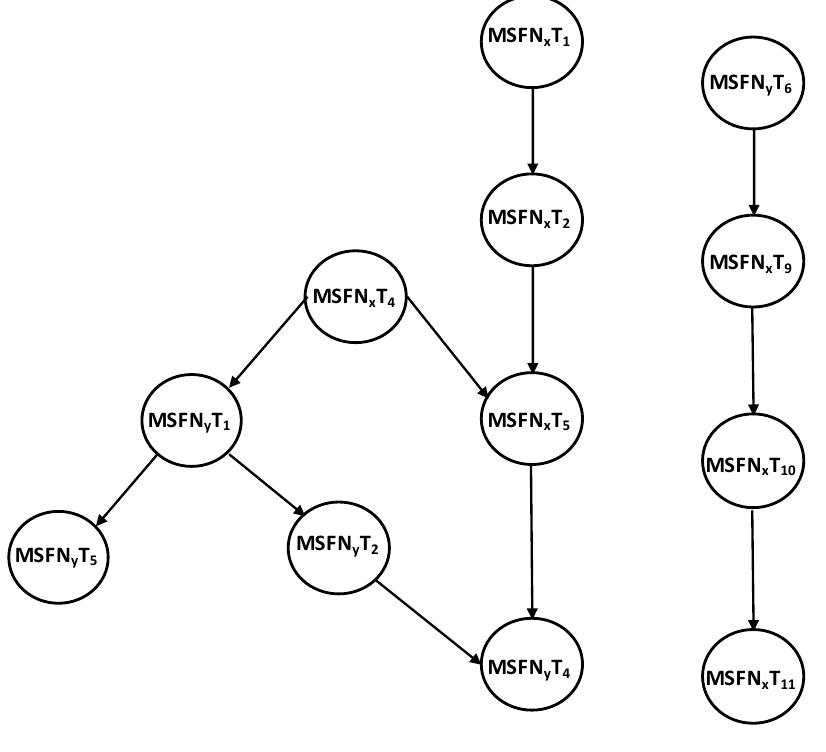
Figure 3. The global graph on the trusted fog node.